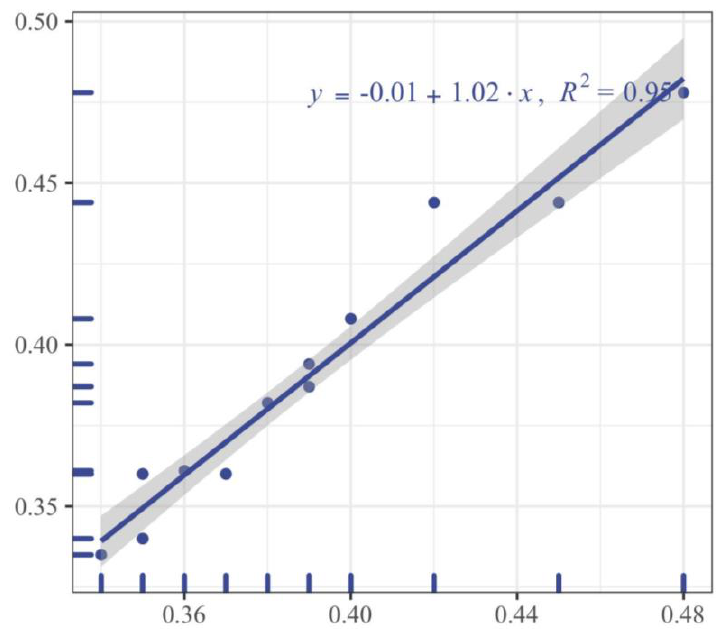
Figure 8. Fitting curve of simulation value and predicted value.